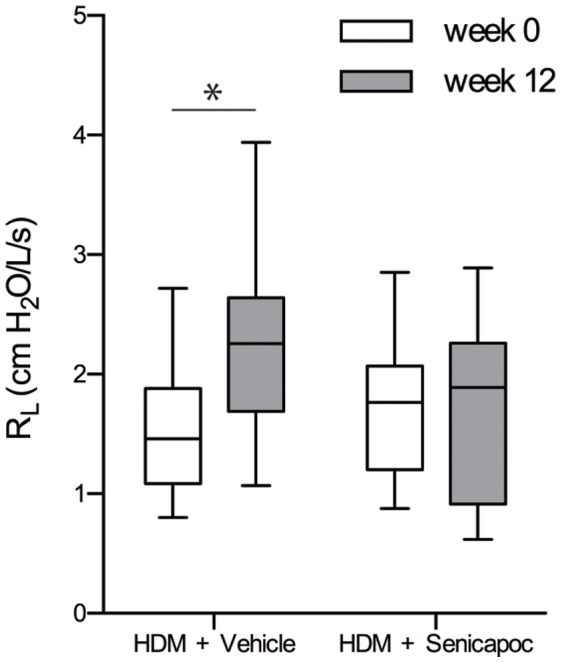
Comparison of resting lung resistance (RL) as assessed prior to the first HDM challenge (week 0) and 12 weeks into the repeated challenge regime in sheep treated with either vehicle or Senicapoc.Horizontal lines represent the median, boxes represent the 25th and 75th percentiles, whiskers represent the 5th and 95th percentiles. n = 10, **P<0.01.